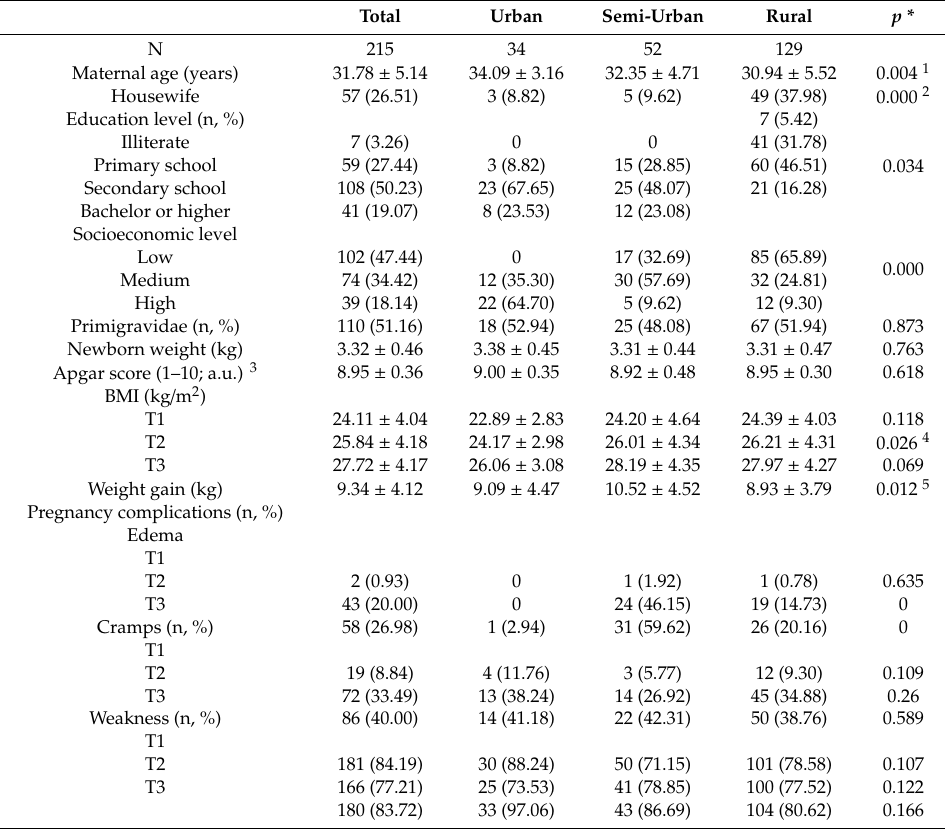
Table 1. Characteristics of 215 women included in the